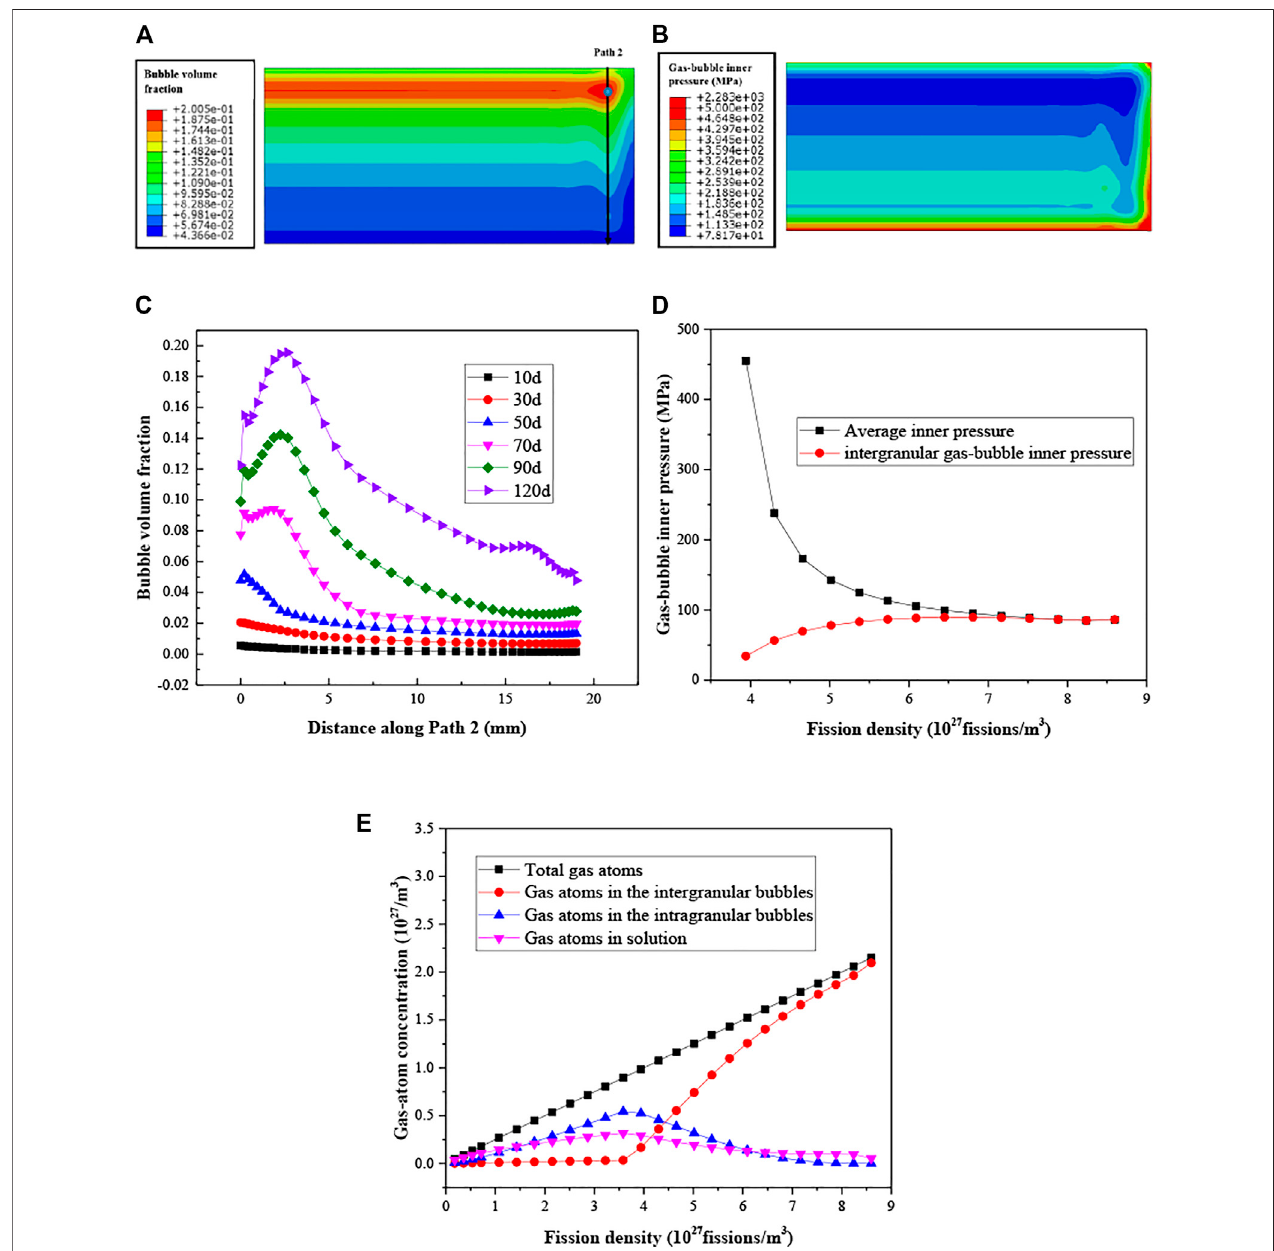
FIGURE13|(A) Distributionoftheporosity; (B) distributionofthegas-bubble innerpressureonthe120 th day; (C) evolutionoftheporosity onPath2; (D) evolution of the gas-bubble inner pressure at higher burn-up levels; (E) evolution of the gas-atom concentration.